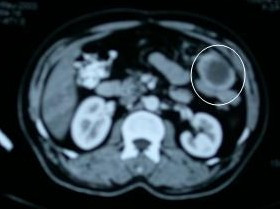
CT scan image showing the omental mass adjacent to bowel loop (circle around the omental mass).